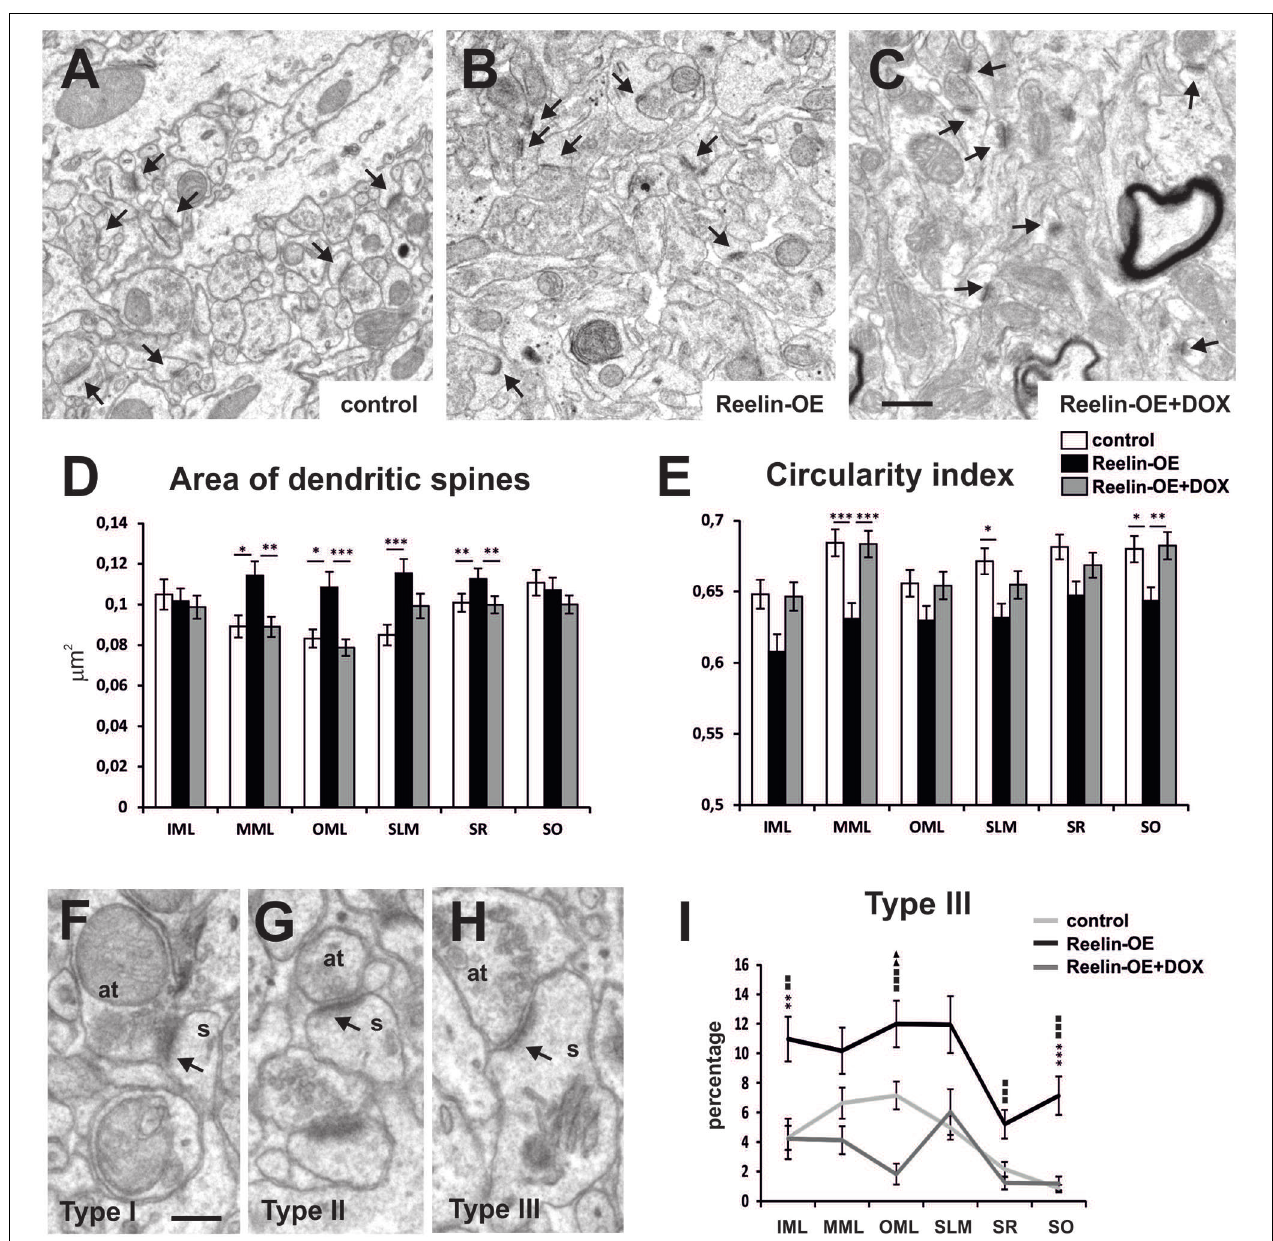
FIGURE 2 | Fine structure of dendritic spines in Reelin-OE mice. (A–C) Electron micrographs illustrating dendritic spines receiving synaptic inputs (arrows) in the inner molecular layer of control, Reelin-OE, and DOX-treated Reelin-OE mice. (D,E) Histograms showing area (D) and circularity index (E) of dendritic spines in different hippocampal layers in control, Reelin-OE, and DOX-treated Reelin-OE mice (mean ± SEM; ∗ p < 0.05, ∗∗ p < 0.01, ∗∗∗ p < 0.001; ANOVA test). (F–H) Electron micrographs showing three types of defined dendritic spines depending on PSD curvature (see text): type I (F) , type II (G) , and type III (H) . (I) Histogram illustrating the percentage of type III dendritic spines in all the hippocampal layers in control, Reelin-OE, and DOX-treated Reelin-OE mice (mean ± SEM; ∗ p < 0.05, ∗∗ p < 0.01, ∗∗∗ p < 0.001 for control vs. Reelin-OE mice; squares for Reelin-OE vs. Reelin-OE + DOX; triangles for control vs. Reelin-OE + DOX mice; ANOVA test). IML, inner molecular layer; MML, medial molecular layer, OML, outer molecular layer; SLM, stratum lacunosum-moleculare; SO, stratum oriens; SP, stratum pyramidale. Scale bars, (A–C) = 0.5 µ m; (F–H) = 200